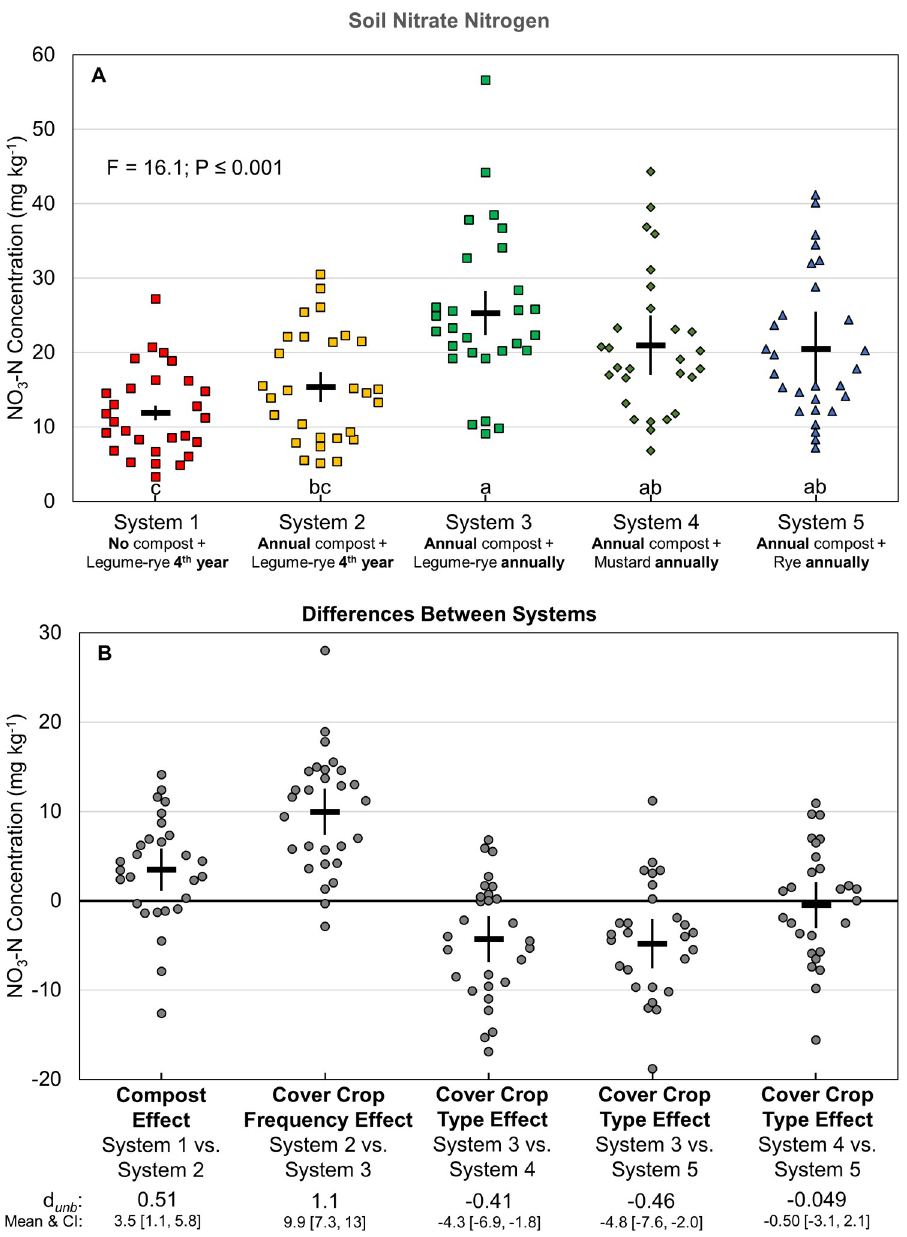
Fig 4. Post-harvest soil nitrate concentrations over seven years of vegetable production. Mean soil nitrate concentrations (A) and mean paired differences between systems (B). Samples were taken at the 0 to 30 cm depth after the 2 nd vegetable crop before winter fallow or cover cropping for years 1 to 7 when two vegetable crops were grown annually. Systems differed by annual compost additions, cover crop type and cover cropping frequency. Error bars are 95% confidence intervals (CI) around the mean (horizontal line). Data points are the 4 replicates each year and are clustered around the mean so as not to obscure the mean and CI. Different lower-case letters above the x-axis in plot A indicate that means are significantly different based on the Tukey-Kramer adjusted family-wise error rate of P � 0.05. The standardized effect size (Cohen’s unbiased d , d unb ) is shown below the x-axis in plot B.